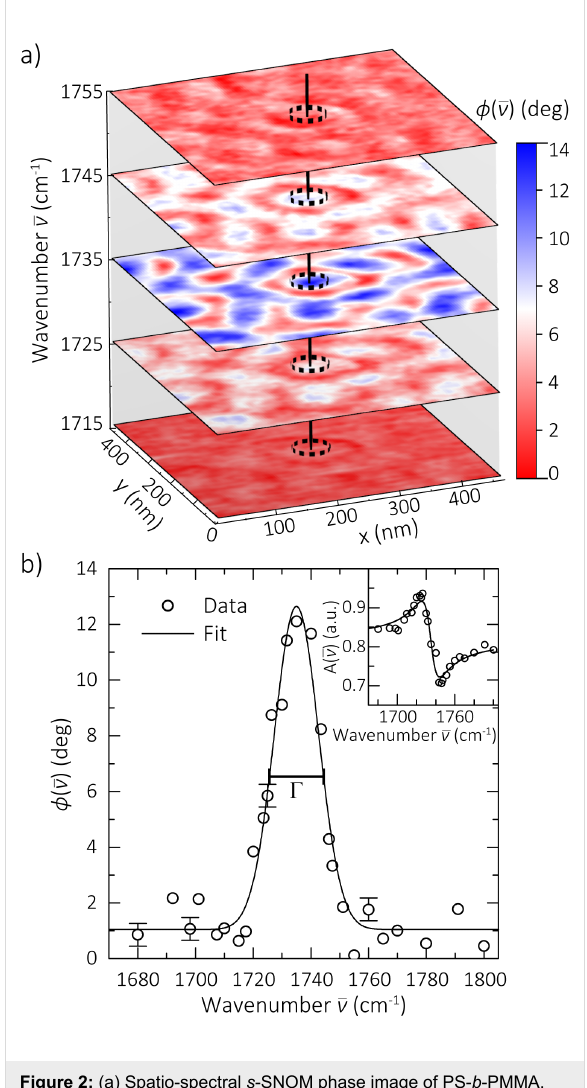
Figure 2: (a) Spatio-spectral s -SNOM phase image of PS- b -PMMA, with carbonyl mode resonant contrast between PMMA (blue) and PS (red) microdomains. (b) Spectrum extracted from a single PMMA microdomain, as illustrated by the vertical line in (a). Error bars shown on select points as reference, calculated as the standard deviation of the nonresonant baseline datapoints. Peak position and linewidth values Γ are extracted computationally from Gaussian fits to spectra at each pixel. Corresponding amplitude spectrum (inset) also shown for completeness, with fit to a dispersive lineshape as a guide to the